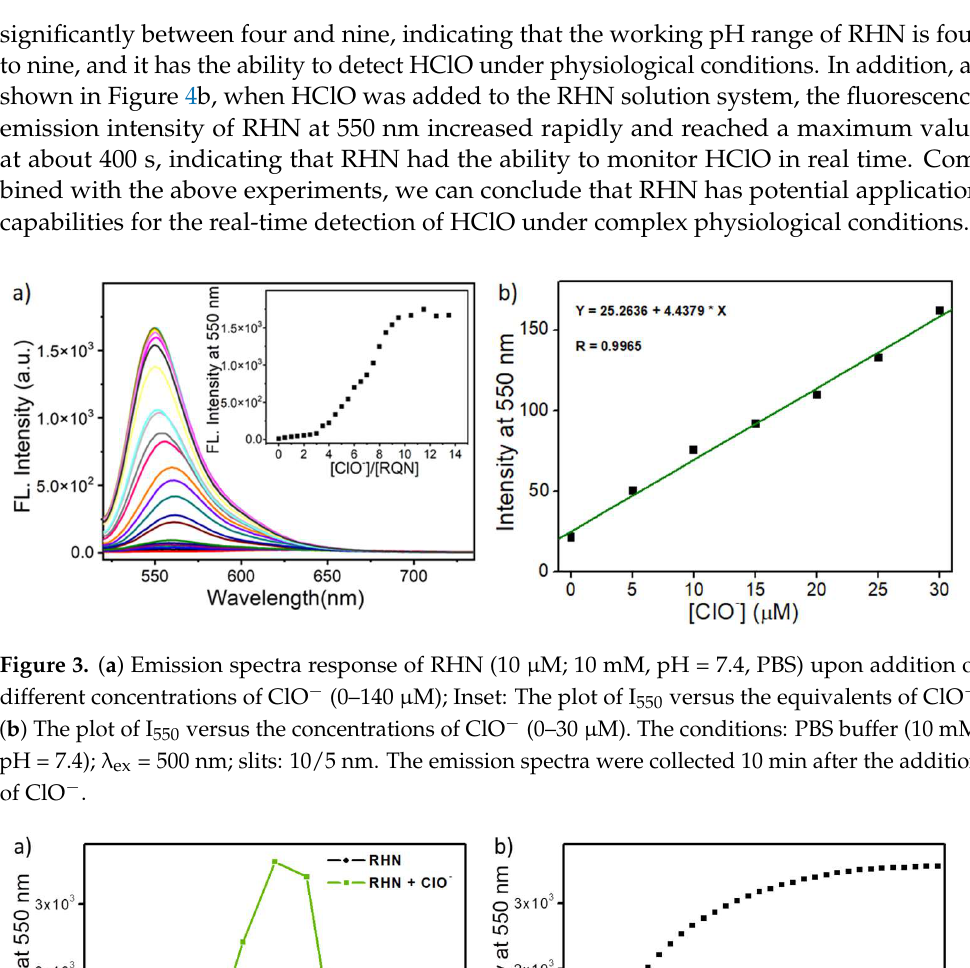
Figure 4. ( a ) Effect of pH on the fluorescence intensity of 10 μM RHN in the absence (black line) and presence of 100 μM ClO − (red line); ( b ) Time dependence of fluorescence intensity of RHN (10 μM) at 550 nm with 10 equiv. of ClO − . The conditions: PBS buffer (10 mM, pH = 7.4); λ ex = 500 nm; slits: 10/5 nm.